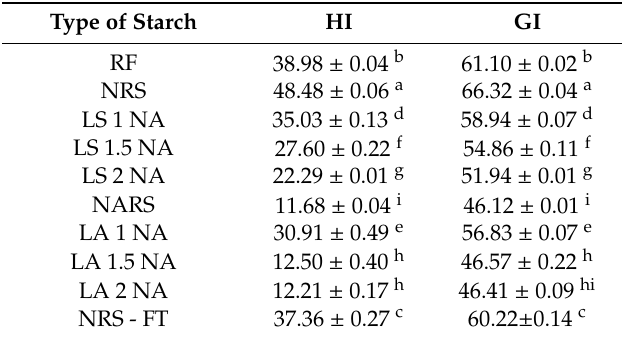
Table 2. Hydrolysis index (HI) and glycemic index (GI) of the Pathumthani 80 (RD 31) rice flour, native starch, and modified